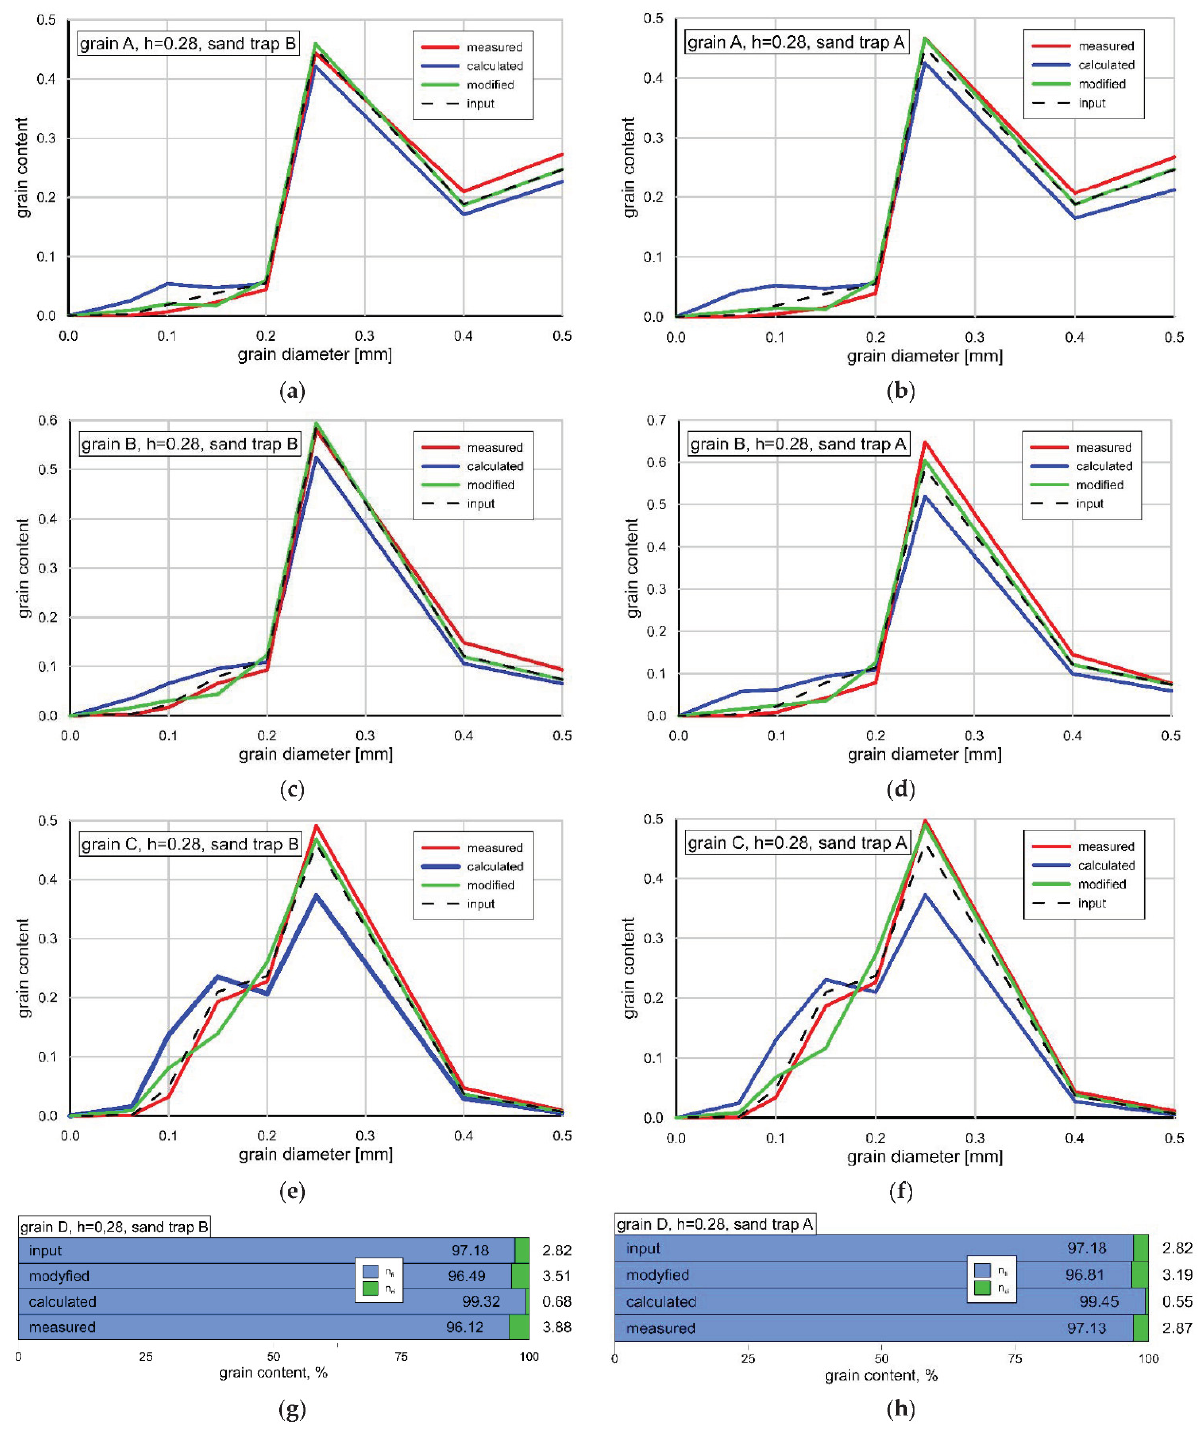
Figure 12. Comparison of calculated and measured grain size distributions in fine fractions and coarse fractions: ( a ) grain A—crest; ( b ) grain A—trough, ( c ) grain B—crest; ( d ) grain B—trough, ( e ) grain C—crest; ( f ) grain C—trough, ( g ) grain D—crest; ( h ) grain D—trough.